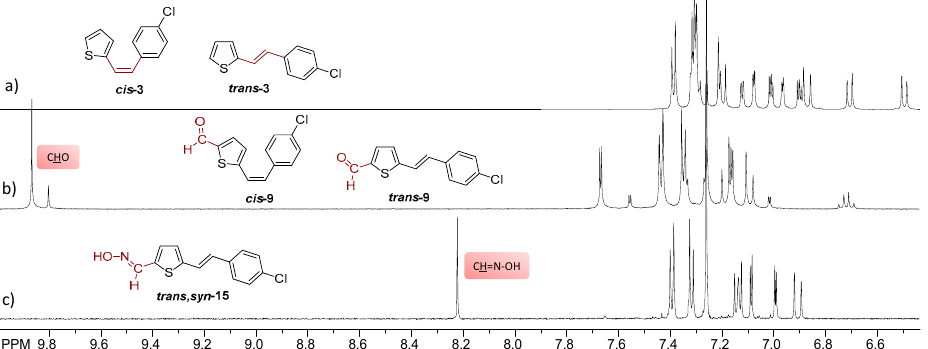
Figure 3. Downfield region of the 1 H NMR spectra (CDCl 3 +CD 3 OD) of the oximes trans,anti - 13 ( a ), trans,anti - 14 ( b ), and trans,anti - 16 ( c ). 2.2. In Silico Prediction of ADME Properties of Thienostilbene Oximes 13 – 18 The structure–property relationships [20,21] with predictive models for calculated compounds 13 – 18 were also analyzed by ACD/Percepta (ver. 14.2.0; Build 2977; ACD/La- boratories, Toronto, ON, Canada), which does not consider the geometrical isomerization. Physico-chemical properties were calculated, specifically the logP values, solubility, and permeability across biological membranes (Table 1). From a medicinal chemistry perspec- tive, the design of drugs capable of penetrating the blood–brain barrier (BBB) and effect- ing the desired biological response is a formidable challenge. Moderately lipophilic drugs cross the BBB by passive diffusion, and the hydrogen bonding properties of drugs can significantly influence their CNS profiles. Polar molecules are generally poor CNS agents unless they undergo active transport across the CNS. Size, ionization properties, and mo- lecular flexibility are other factors observed to influence the transport of an organic com- pound [22]. Lipophilicity is one of the most important physical properties that can affect the potency, distribution, and elimination of a drug in the body [23]. In general, the solubility of selected oximes 13 – 18 was low. Nitro derivative 17 and dimethylamino derivative 18 showed the highest solubility (0.01 mg/mL). All of the com- pounds showed an optimal lipophilicity value, meaning they should readily penetrate the BBB, since the majority of CNS drugs have logP within the range of 3.5 to 4.5 (ACD/Per- cepta (ver. 14.2.0; Build 2977; ACD/Laboratories, Toronto, ON, Canada). Moreover, esti- mations of the CNS factor displayed their high penetrant ability. Plasma protein binding